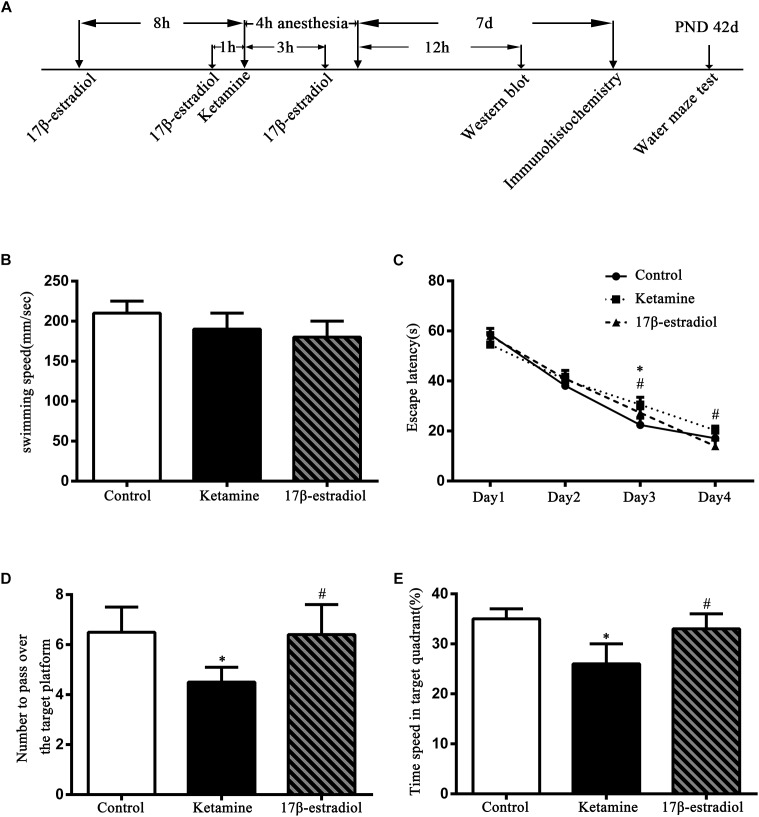
Diagram of the study and results of Morris water maze trials. (A) The diagram of the timeline of the study. (B) Swimming speed comparison between three groups during the training. There was no difference among three groups. (C) Comparison of the latency to reach the hidden platform. ∗p < 0.05 compared with control group, #p < 0.05 compared with ketamine group. (D) Comparison of the numbers to pass over the target platform. ∗p < 0.05 compared with control group, #p < 0.05 compared with ketamine group. (E) Comparison of the time spent in target quadrant. ∗p < 0.05 compared with control group, #p < 0.05 compared with ketamine group. Data are present as the means ± SEM. n = 6 in each group.